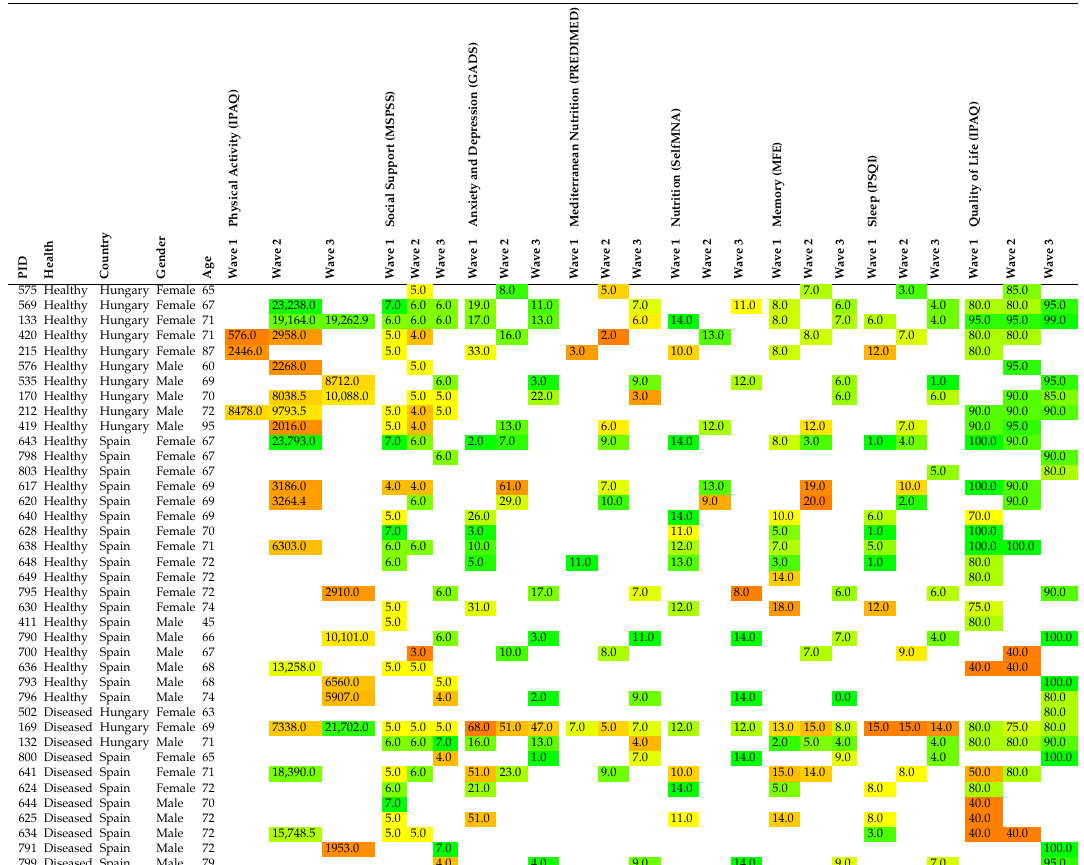
Table A2. PRO numeric scores from answers by questionnaire ( N = 39 participants).